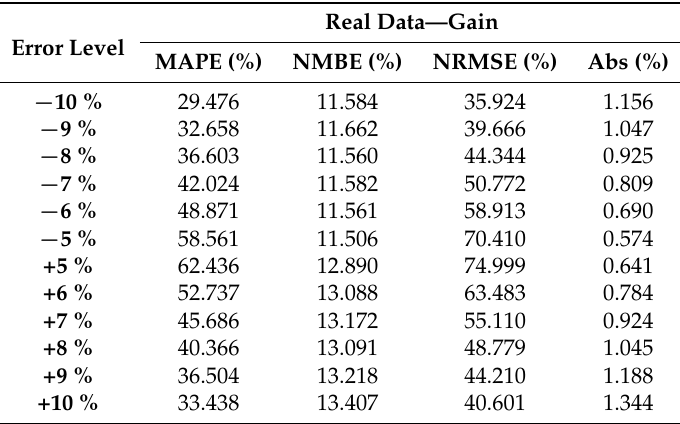
Table 3. Error indicators for different gain error levels—Real